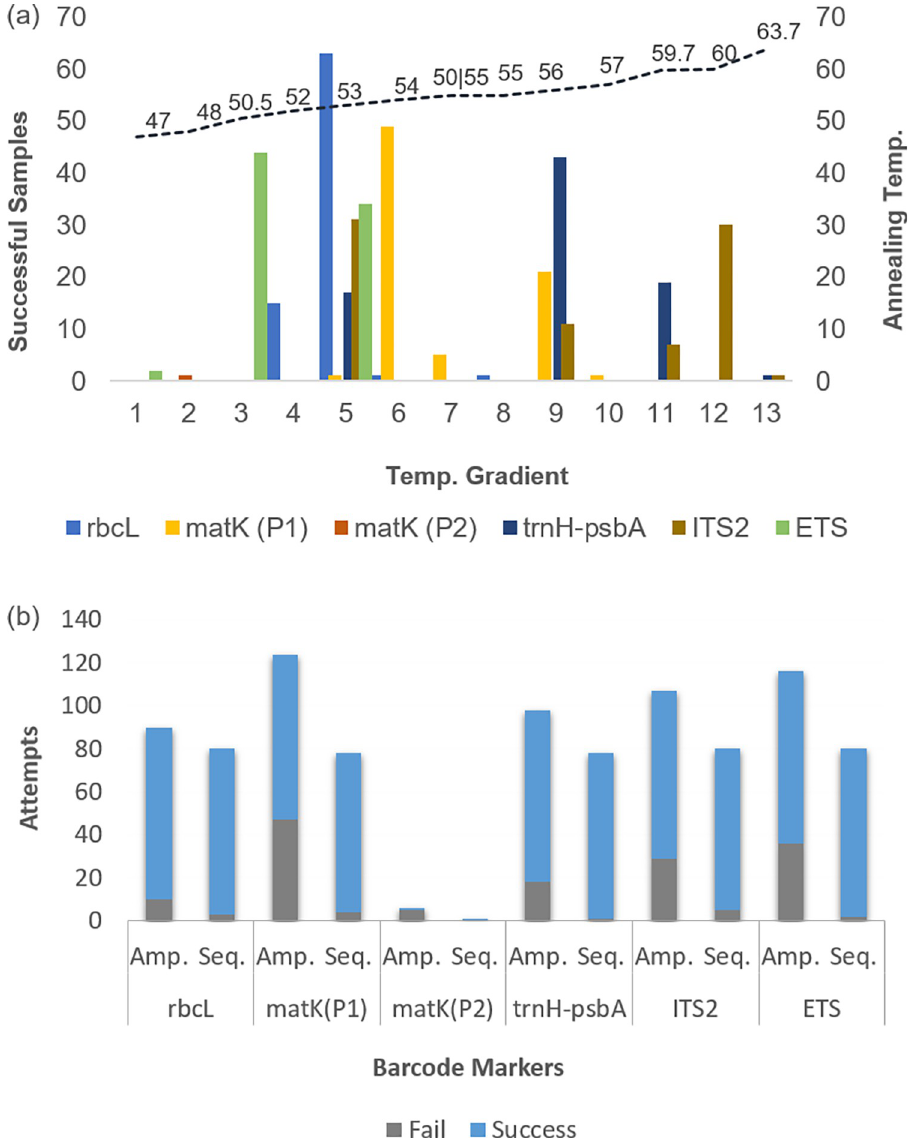
Fig 1. Attempts of PCR amplification and sequencing for the DNA barcode markers employed (a) Annealing temperature gradients employed for amplification, where ’50|55’ indicates an attempt of dual annealing temperature (55 initial and 50 final). (b) Success and failures in the samples attempted for PCR amplification and sequencing. Salicornia sp . belonging to the various DNA barcode markers viz., rbcL (n = 77), matK (n = 75), trnH-psbA (n = 77), ITS2 (n = 75) and ETS (n = 78) (Fig 1(B)). Taxonomic validation using nrDNA and cpDNA barcode markers The specimens collected from the RAK and UAQ populations were morphologically identified to the genus level as Salicornia . The taxonomic evaluation was further done using the NCBI BLAST. The cpDNA barcodes revealed a multi-species association between 98–100% identity. In trnH-psbA, the barcode identity was less than 97% due to a lack of sufficient DNA barcode sequences from Salicornia genera; accessions with the closest match belong to Salicornia’s